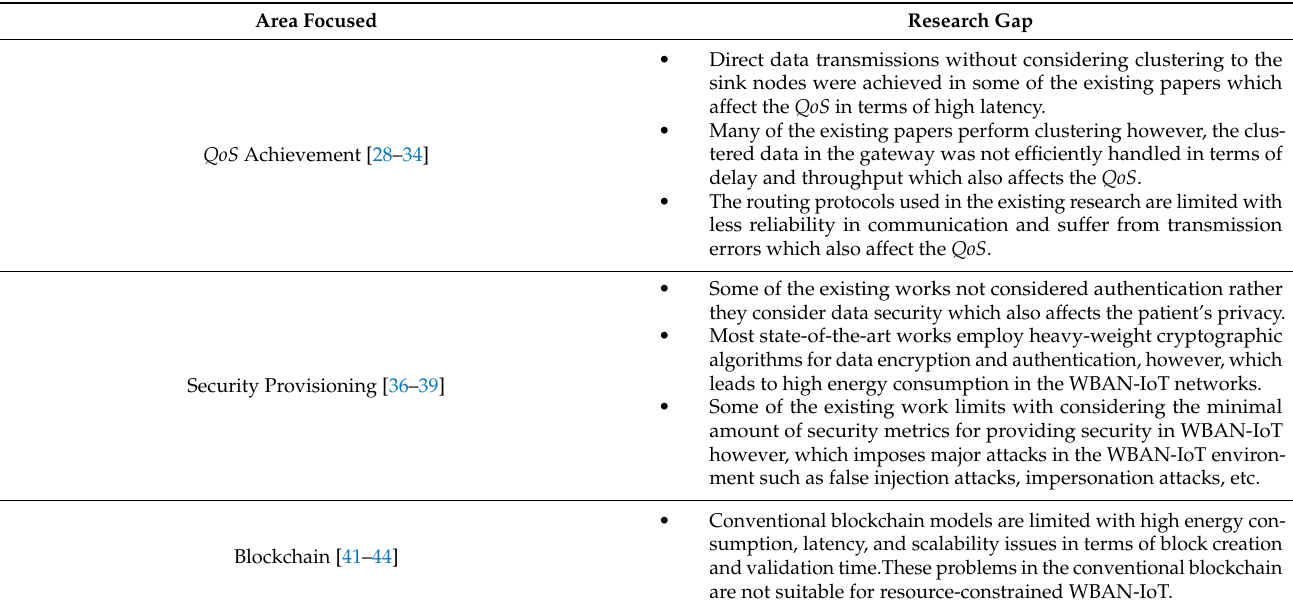
Table 1. Research